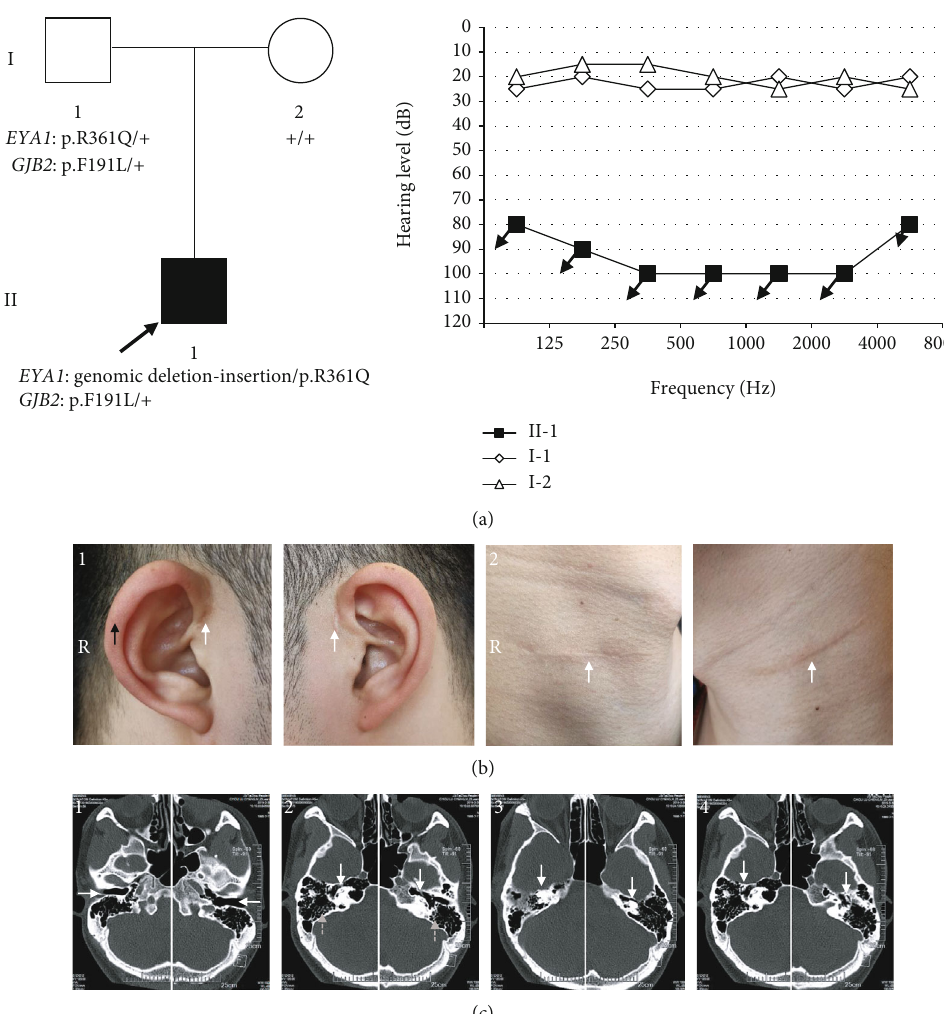
Figure 1: Pedigree, genotype, and phenotype characterization of the family. (a) Pedigree, genotype, and audiograms. Proband II-1 is pointed by the black arrow, and hearing loss is indicated by the black square. The audiograms showed profound sensorineural hearing loss in II-1 and normal hearing loss in his parents. (b) Right cup-shaped outer ear is showed by a black arrow in b1; two white arrows in b1 and b2 indicate bilateral surgical scars of preauricular fi stula and cervical branchial cyst, respectively. (c) Findings in temporal HRCT: c1: bilateral lower external auditory canals; c2: white solid and grey dotted arrows indicate cochlear hypoplasia and overgasi fi cation of mastoid cells, respectively; c3: malformed semicircular canal; c4: deformed ossicular